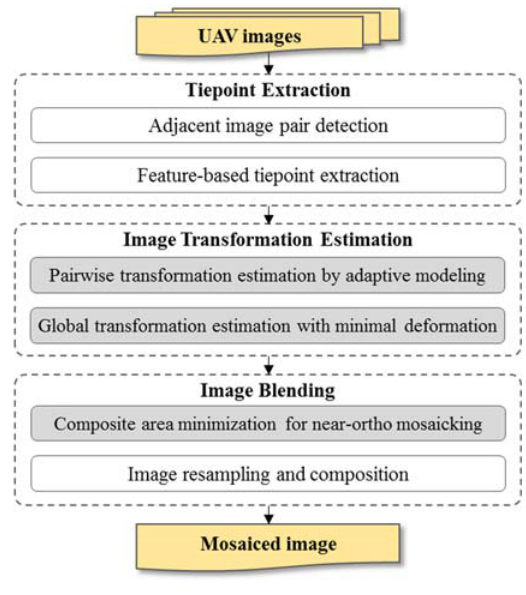
Figure 1. Work flow for the proposed